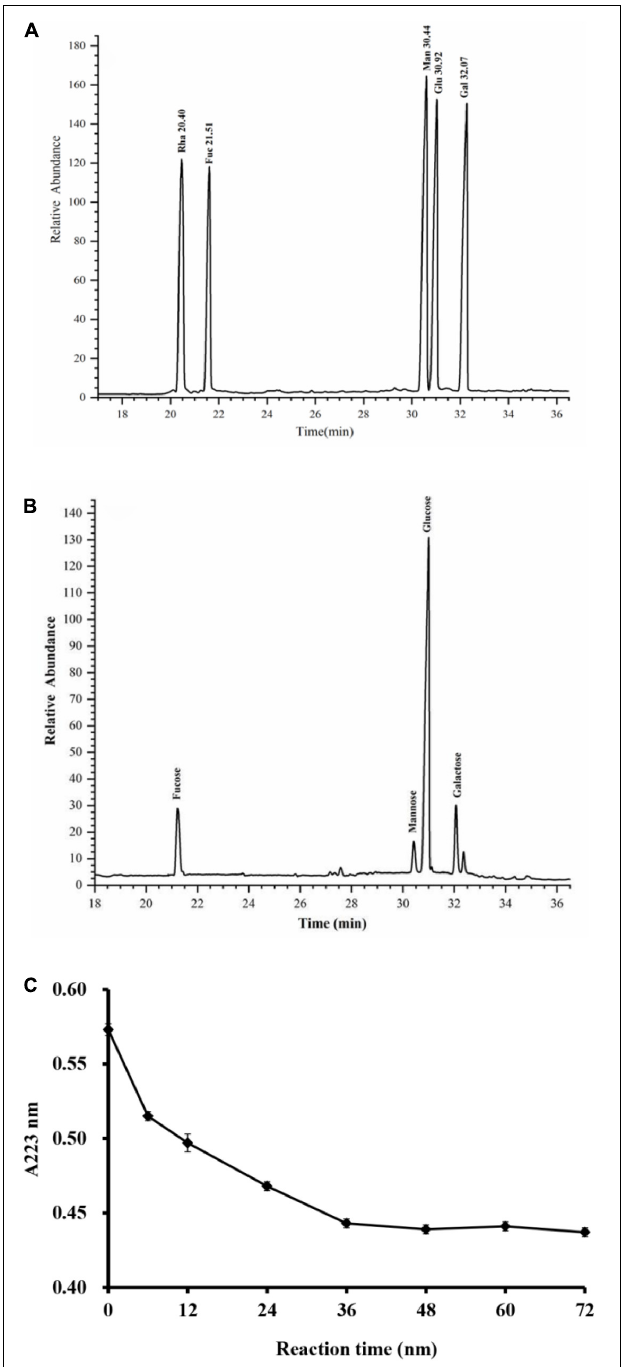
FIGURE 3 | GC–MS chromatograms of monosaccharide standards (A) and RGLP-1 (B) ; The periodic acid consumption of RGLP-1 (C)